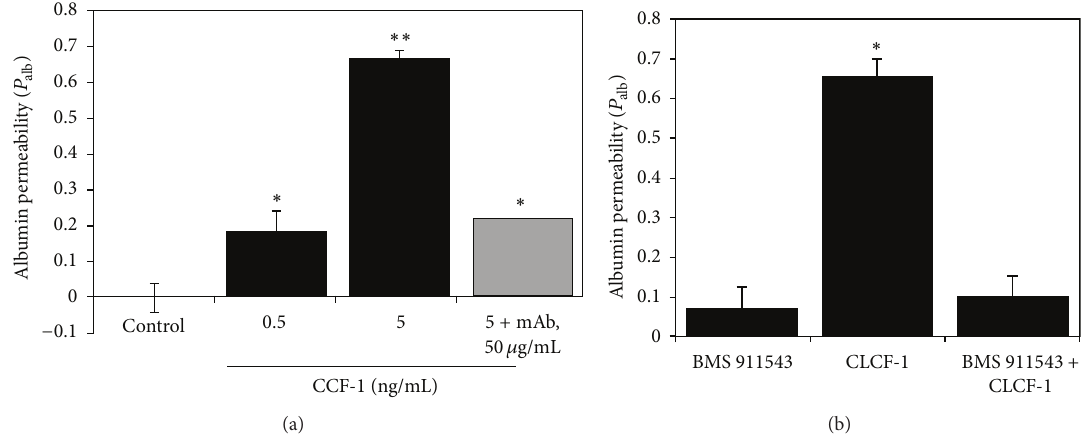
Figure 3: (a) Isolated rat glomeruli were incubated with the indicated concentrations of CLCF-1 for 15 minutes at 37 ∘ C. Anti-CLCF-1 antibody abrogated this effect with maximum effect at antibody concentration of 50 𝜇 g/mL. 𝑁 = 10 at each concentration. Values are mean ± SEM. ∗ 𝑃 < 0.05 , ∗∗ 𝑃 < 0.001 versus control. (b) JAK inhibition of CLC effect on 𝑃 . Isolated rat glomeruli were incubated with 10ng/mL CLCF-1 alb for 10 minutes at 37 ∘ C either with or without pretreatment by 5 nM JAK2 inhibitor BMS911543 for 15min at 37 ∘ C. Additional glomeruli were was blocked by pretreatment with BMS911543. ∗ 𝑃 < 0.001 versus BMS911543 alone or treated with BMS911543 alone. CLCF-1 increased 𝑃 alb CLCF-1 after